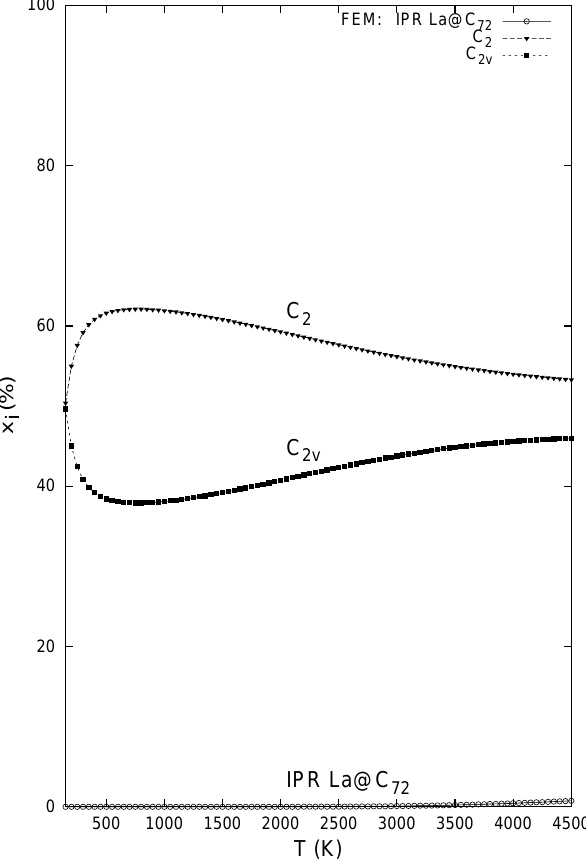
Figure 2. Relative concentrations of the La@C B3LYP/6–31G (cid:3) (cid:24) dz energetics, B3LYP/3–21G (cid:24) dz entropy, and FEM